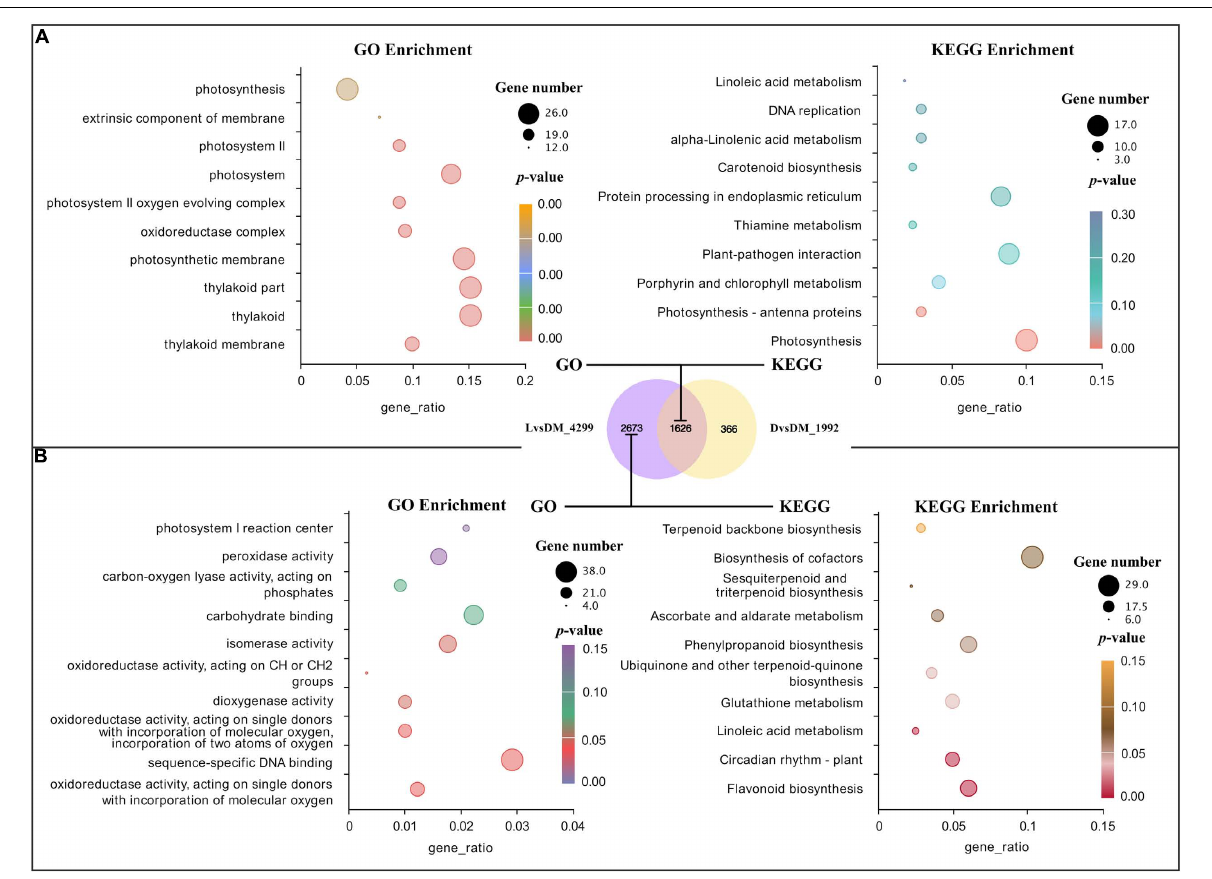
Frontiers in Plant Science |